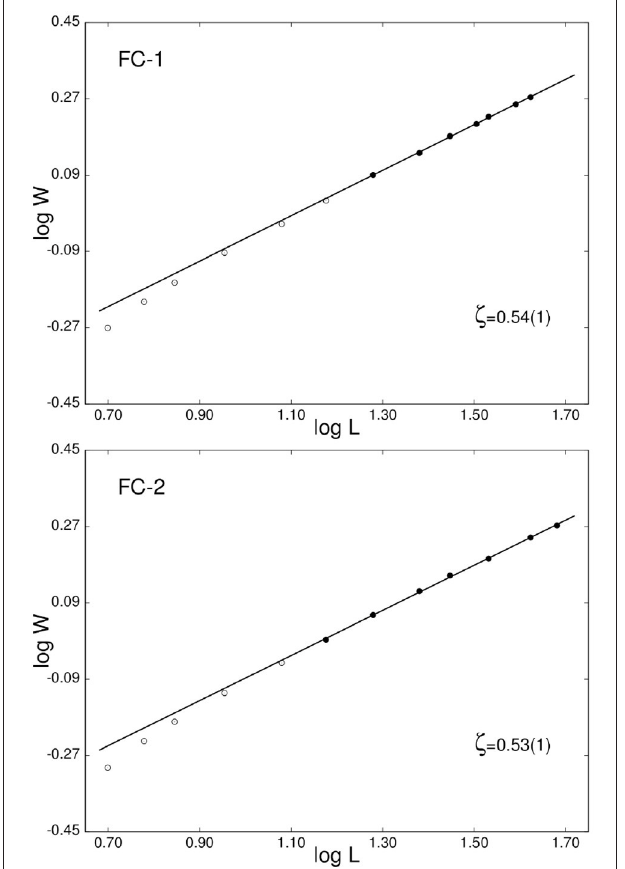
FIGURE 11 | Log-log plots for average roughness, W , as a function of system size, L , for a large number of fractured samples. Disorder magnitude is D = 2. Shown at the top (FC-1) is the result obtained with the “maximum normal stress” criterion, Equation (84). Shown below (FC-2) is the result obtained with the “maximum shear stress” criterion, Equation (77). Black dots indicate those values to which the straight line has been fit using linear regression.